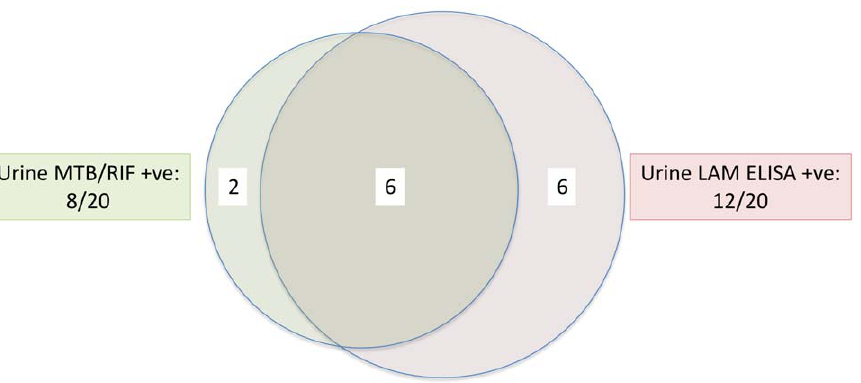
Figure 2. Venn diagram showing the proportions of patients diagnosed by urine MTB/RIF and/or urine LAM ELISA in sputum scarce m.tb culture positive patients. 6 patients were both urine MTB/RIF and LAM ELISA positive; 6 patients were urine LAM ELISA positive, but MTB/RIF negative, while 2 patients were urine MTB/RIF positive, LAM ELISA negative.